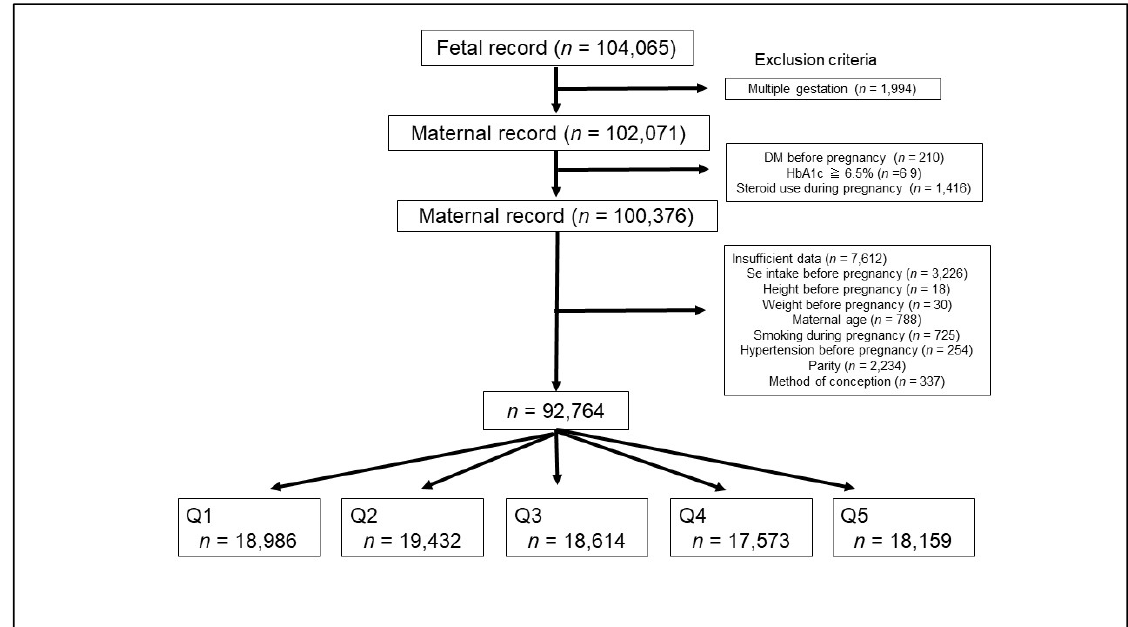
Figure 1. Participant selection flowchart.